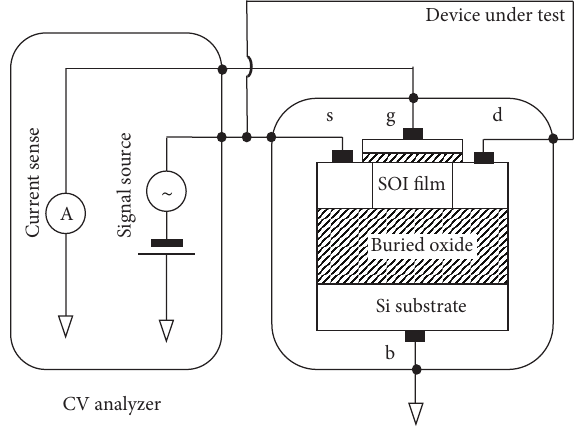
Figure 5: Schematic of the experimental setup for the gate to channel capacitance measurement, based on [13]